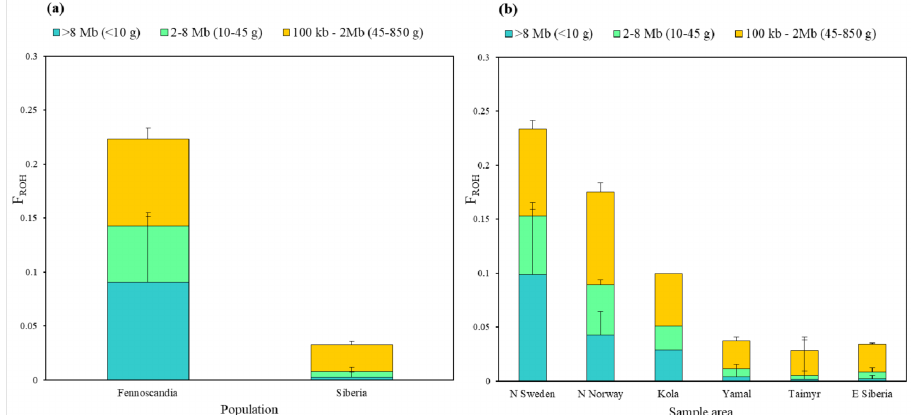
Figure 5. Mean genomic inbreeding coefficients (F ROH ) with standard deviation for individuals in northern Fennoscandian and Siberian populations ( a ) and separated into subpopulations ( b ). Orange bars show inbreeding due to close relations deep back in history (45–850 generations, >100 kb–2 Mb), Green bars shows show inbreeding due to close relations 10–45 generations back (2–8 Mb) and blue bars show inbreeding due to recent ancestors less than 10 generations back (>8